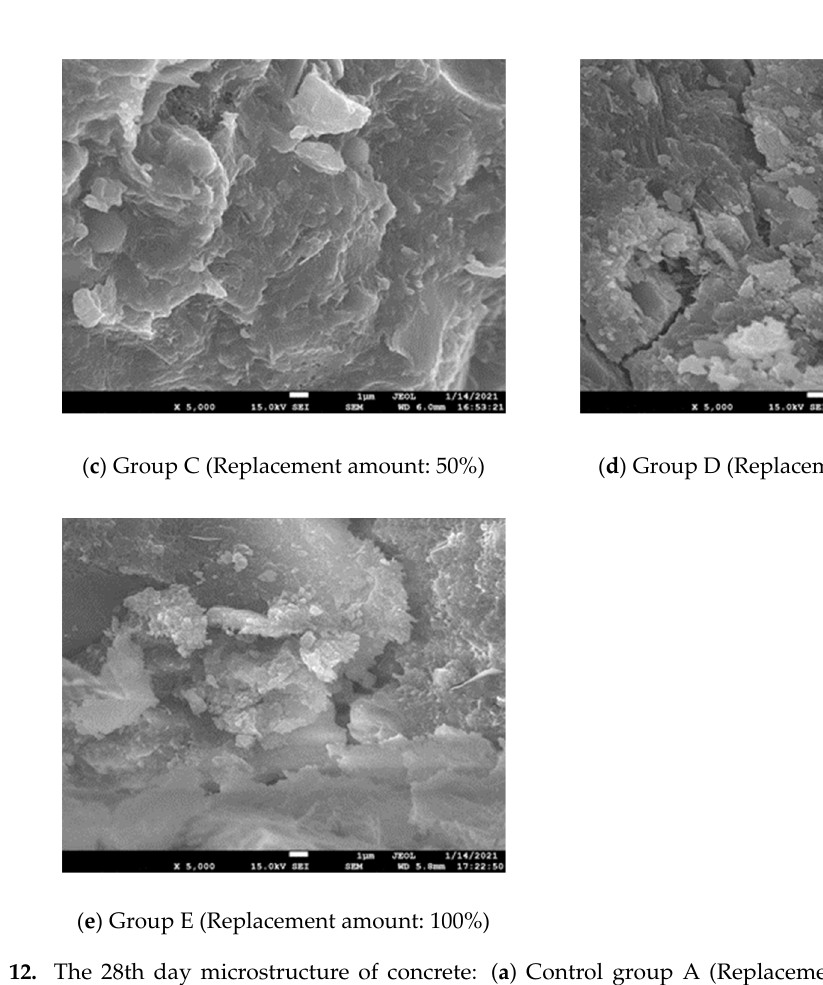
Figure 12. The 28th day microstructure of concrete: ( a ) Control group A (Replacement amount: 0%); ( b ) Group B (Replacement amount: 25%); ( c ) Group C (Replacement amount: 50%); ( d ) Group D (Replacement amount: 75%); ( e ) Group E (Replacement amount: 100%).